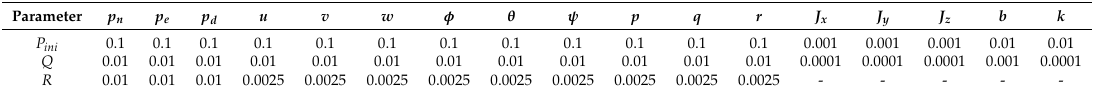
Table 4. EKF parameter values used in simulations.